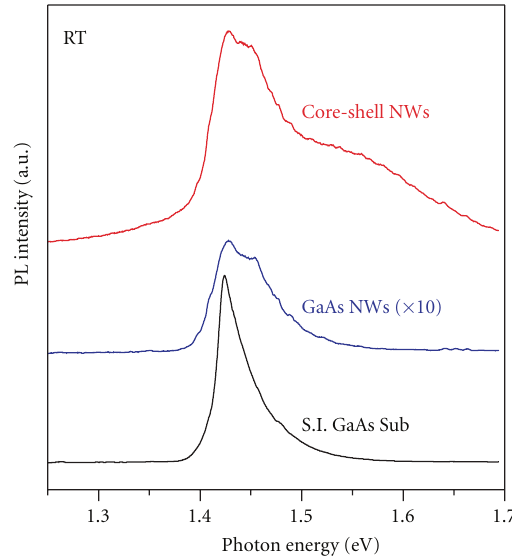
Figure 19: PL spectra of core-shell nanowires (NWs), bare GaAs nanowires, and reference semi-insulating GaAs substrate. Intensity of core-shell nanowires is about 20 times larger than that of bare GaAs nanowires